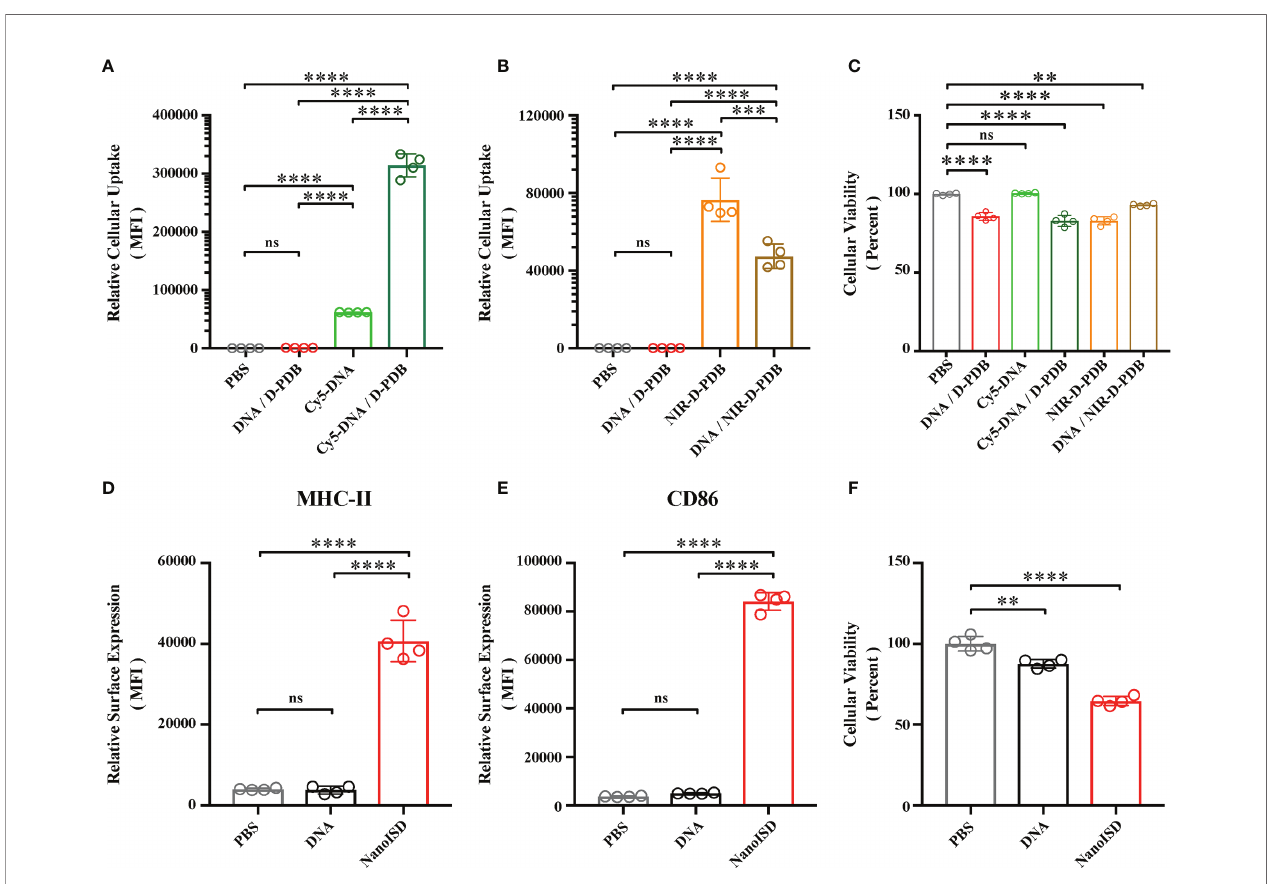
FIGURE 4 | NanoISD Enhances Cellular Uptake and Immunostimulatory Activity of ISD In Vitro . (A) Flow cytometry analysis on the cellular uptake of 45 nM DNA ( i.e. Cy5-labeled phosphorothioate-capped 95-BP dsDNA). Flow cytometry was conducted 4 hours after indicated treatment. The median fl uorescence intensity (MFI) of Cy5-labeled DNA was quanti fi ed. (B) Flow cytometry analysis on the cellular uptake of 1.1 µM D-PDB ( i.e. NIR-D-PDB), which corresponds to 45 nM DNA for a N/P charge ratio of 4. Flow cytometry was conducted 4 hours after indicated treatment. The MFI of NIR-664-labeled D-PDB was quanti fi ed. (C) Cellular viability determined 4 hours after indicated treatment as assessed by DAPI staining. Percent viable is relative to cells treated with PBS. (D) Flow cytometry analysis of the BMDC maturation marker, MHC-II conducted 24 hours after treatment of either PBS, 45 nM DNA ( i.e. phosphorothioate-capped 95-BP dsDNA), or NanoISD at a dose corresponding to 45 nM. The MFI of anti-MHC-II-APC-Cy7 was quanti fi ed. (E) Flow cytometry analysis of the BMDC maturation marker, CD86 conducted 24 hours after treatment of either PBS, 45 nM DNA ( i.e. phosphorothioate-capped 95-BP dsDNA), or NanoISD at a dose corresponding to 45 nM. The MFI of anti- CD86-PE-Cy7 was quanti fi ed. (F) Cellular viability determined 24 hours after indicated treatment as assessed by DAPI staining. Percent viable is relative to cells treated with PBS. A one-way ANOVA with Tukey test was used for statistical analysis. ****p < 0.0001, ***p < 0.005, **p < 0.01. ns, not signi fi